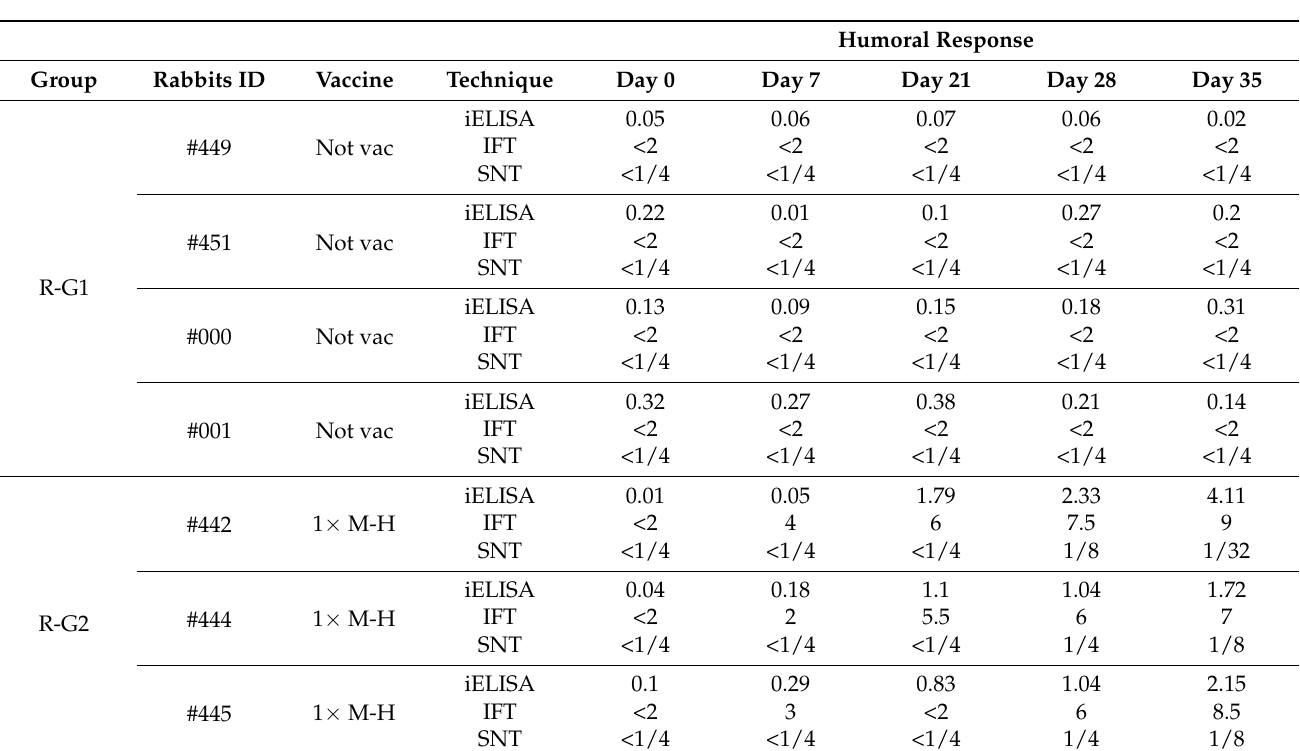
Table 2. Serological responses of rabbits (study 2) after vaccination and before challenge. Data were measured by indirect ELISA (RI10), immunofluorescence titration (IFT = titre in log2) and seroneutralization (SNT = titre).